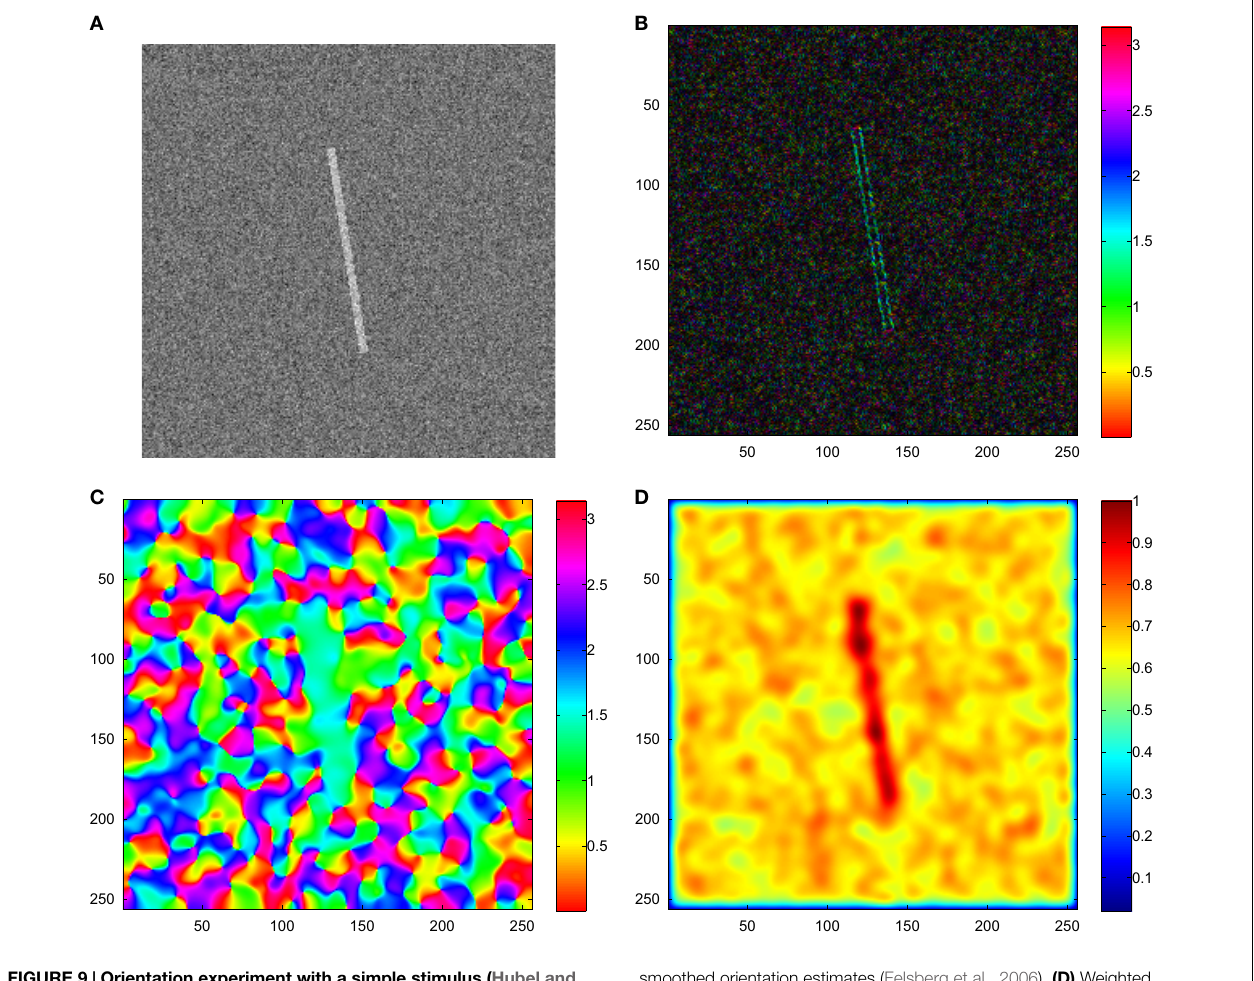
FIGURE 9 | Orientation experiment with a simple stimulus (Hubel and Wiesel, 1959) . (A) Example pattern with noise. (B) Raw orientation estimates computed with the Scharr filter (Scharr et al., 1997). (C) Channel